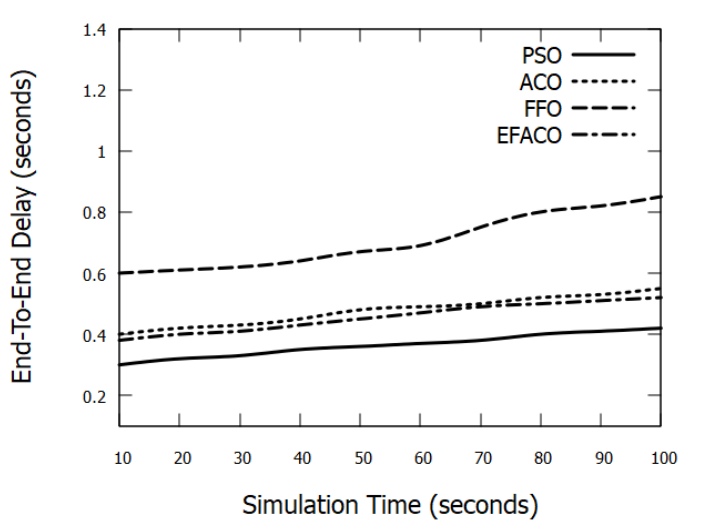
Figure 8. Comparison between proposed PSO, ACO, FFO, EFACO for End-to-End Delay with simulation time. Table 3. End-To-End-Delay in (Seconds) in Figure